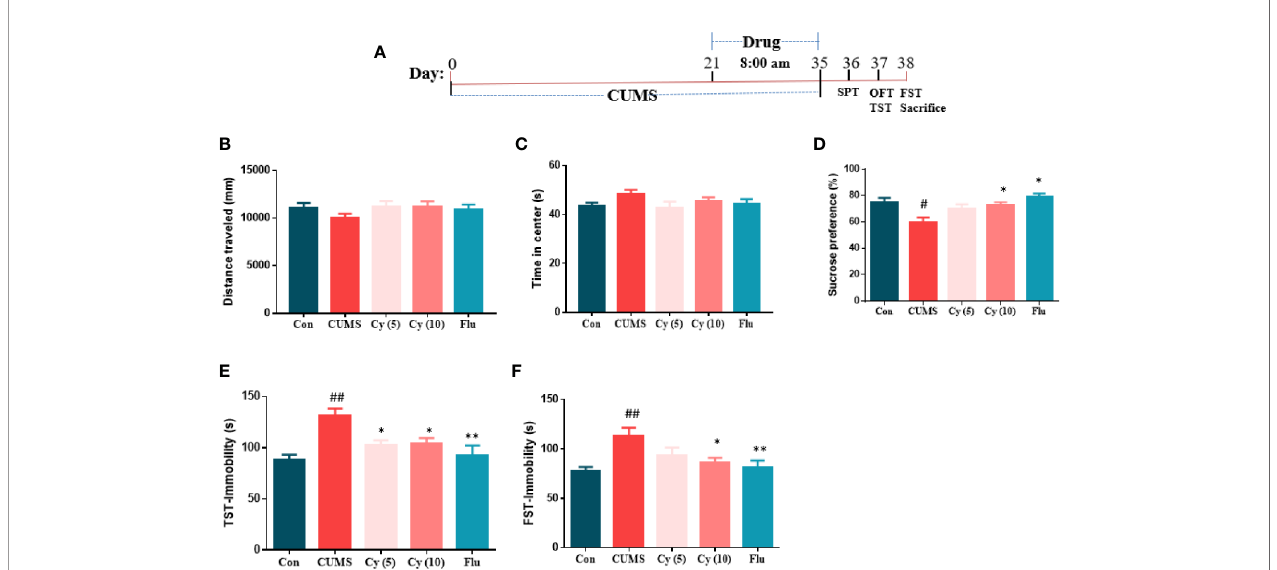
FIGURE 1 | Experimental procedures and behavioral assessment after 5 weeks. Drug administration sustained 2 weeks during the CUMS procedure (A) . CUMS mice exhibited decreased sucrose preference rate in SPT (D) , and extended immobility time in TST (E) and FST (F) , which were all reversed by Cy treatment. No signi fi cant difference was found in OFT (B, C) . Data are represented as mean ± SEM. # p < 0.05 and ## p < 0.01 vs. Con group. * p < 0.05 and ** p < 0.01 vs. CUMS